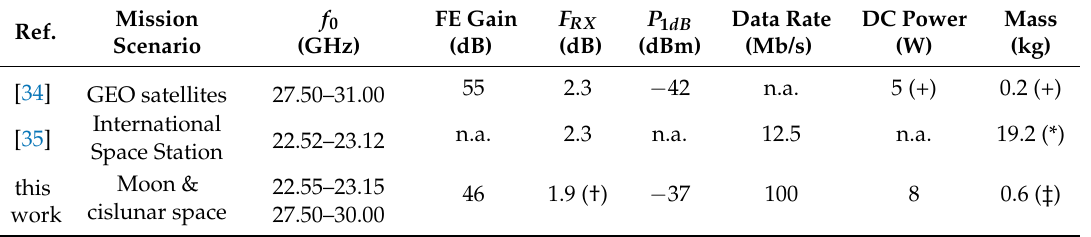
Table 7. State-of-the-Art for K/Ka-Band Receivers for Space Applications.